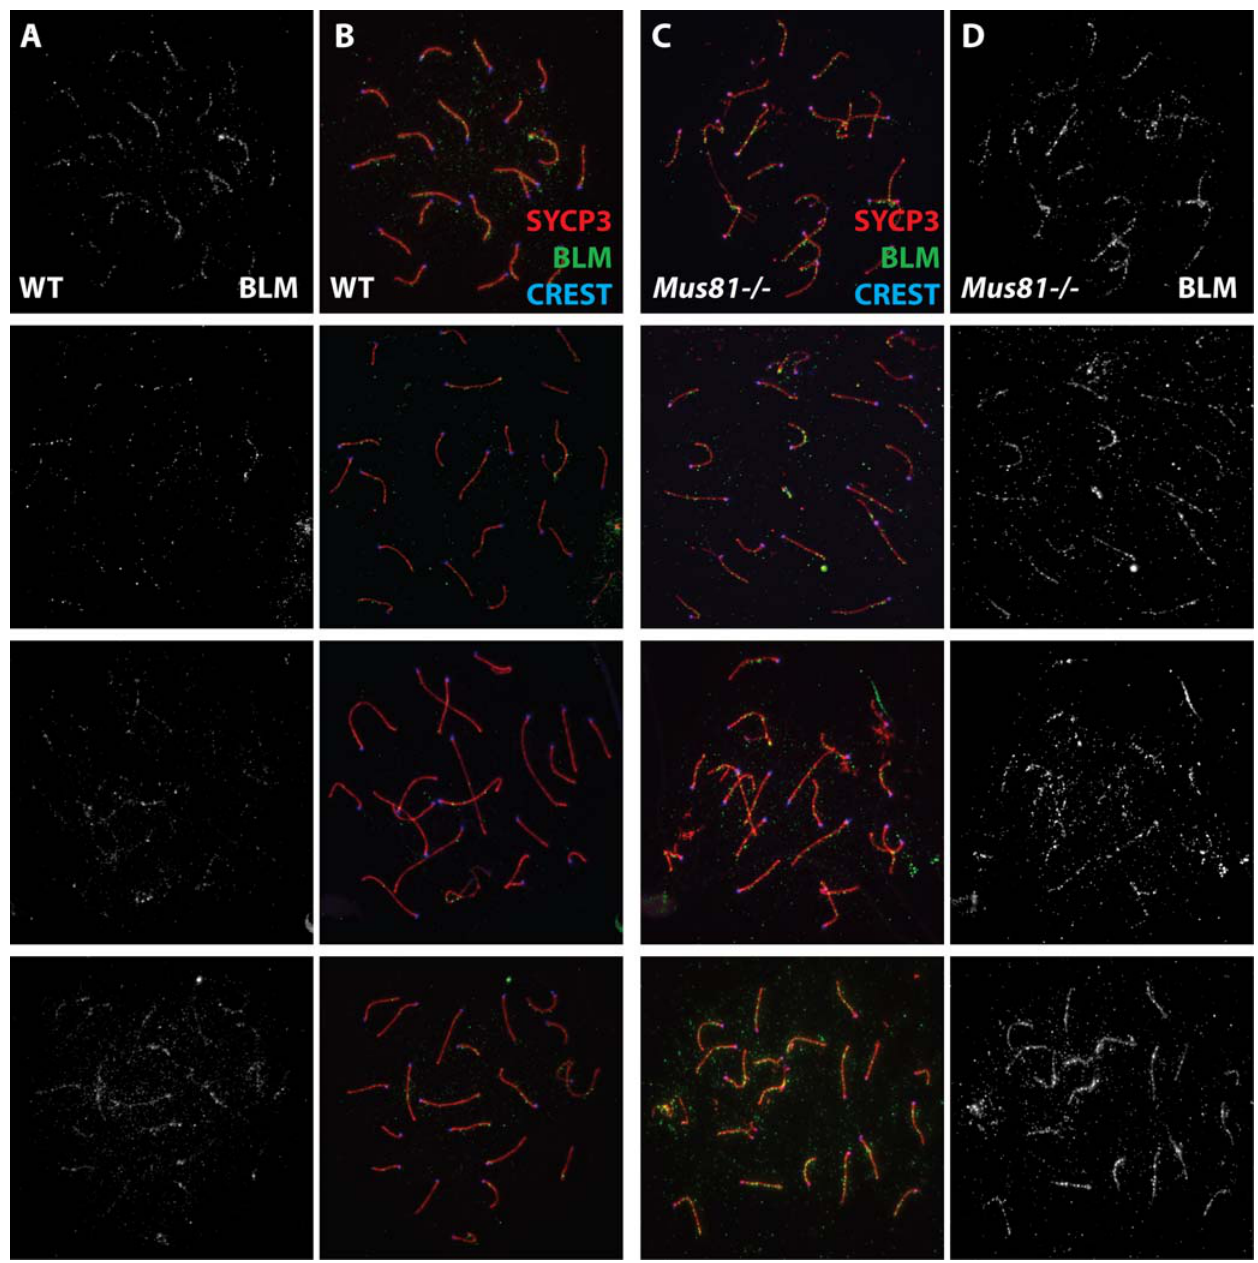
Figure 3. BLM localization persists into late pachynema in Mus81 2 / 2 spermatocytes. WT (column A, B) and Mus81 2 / 2 (column C, D) pachytene spermatocytes were stained with antibodies raised against SYCP3 (red), BLM (green) and CREST autoimmune serum (blue). BLM focus number is higher in late pachytene cells in the mutant as opposed to WT cells, as can be seen when visualizing the BLM only image (white) (columns A, D). mutant males, compared to the Mlh3 2 / 2 single mutant males analyzed for meiotic progression and chiasmata frequency. Testis sizes of the Mus81 2 / 2 and Mlh3 2 / 2 :Mus81 2 / 2 mice were and both were severely reduced when compared to WT (average chiasmata counts per cell were WT 23.79 6 1.78, Mlh3 2 / 2 1.79 reduced compared to wild-type males (Table 1), and this is 6 0.80, Mus81 2 / 2 : Mlh3 2 / 2 0.48 6 0.70: Figure 6J–L, with the evident by the reduced cellularity of the seminiferous epithelium in the double mutant males (Figure 6D–F). Both the single Mlh3 2 / 2 counts from Mlh3 2 / 2 single null and Mus81 2 / 2 : Mlh3 2 / 2 being significantly different p , 0.0001). Thus, it appears that MUS81 and double Mus81 2 / 2 :Mlh3 2 / 2 mutants had no mature sperma- and MLH3 generate COs by independent pathways, as exempli- tozoa within their epididymides (Table 1), and no overt differences fied by the residual crossovers in the Mlh3 null mice, and that there were observed in localization patterns for different prophase I is a possible third pathway for generation of COs, due to the markers between the two genotypes (MLH1, Figure 6G–I). presence of a small number of remaining COs in the double nulls. Chiasmata were reduced in the Mus81 2 / 2 :Mlh3 2 / 2 double